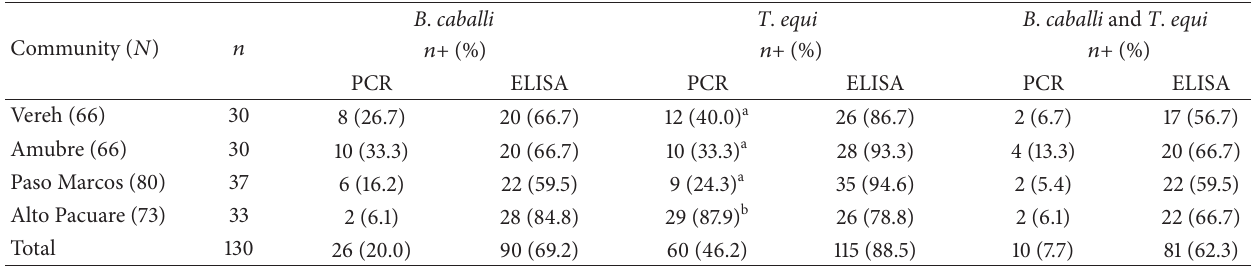
Table 2: Absolute frequency and percentage of horses testing positive for B . caballi and T . equi using nested PCR and c-ELISA in four indigenous communities of Costa Rica ( 𝑛 =